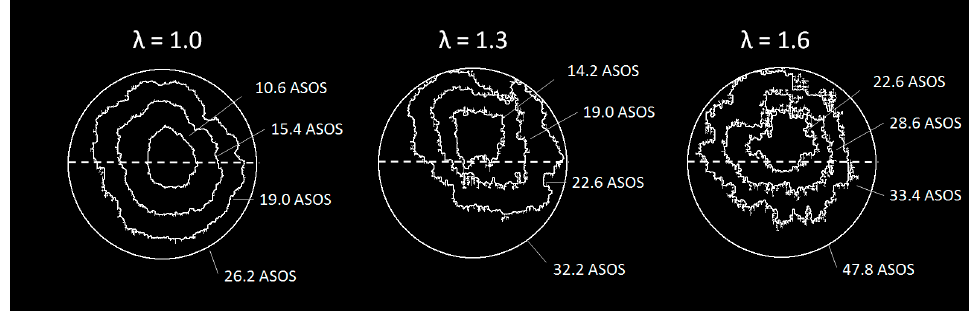
Figure 16. Typical evolution of the flame front contours in the early combustion stages. Energies 2017 , 10 , 1337